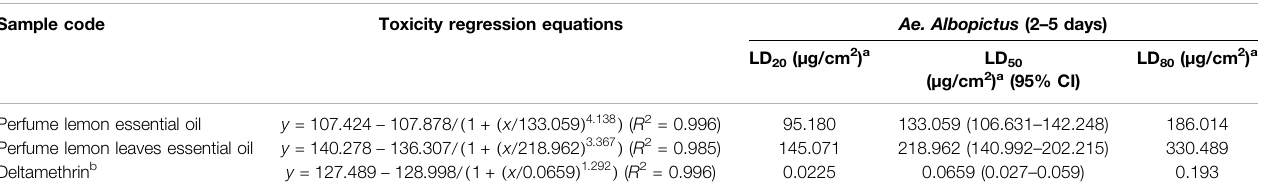
TABLE 5 | Acute toxicity of the two essential oils against Ae. albopictus ( μ g/cm 2 ). Sample code Toxicity regression